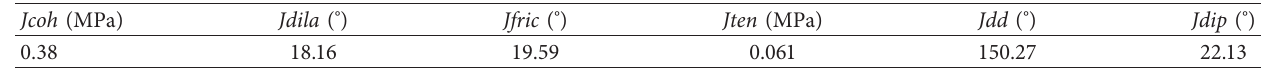
Table 4: Back-analysis results of joint parameters.